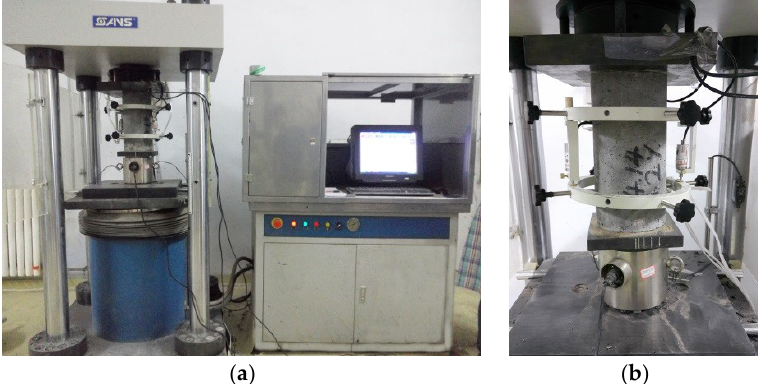
Figure 4. Equipment and instrument used in the test: ( a ) overall perspective; ( b ) testing device for load and deformation.